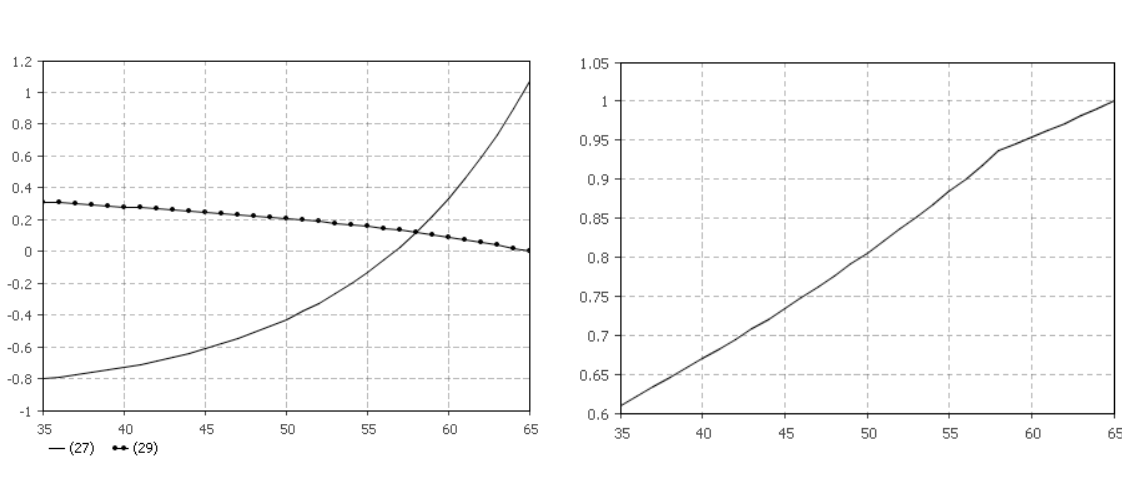
Figure 5. Finding the switching point of control ( ) 0.01 i = problem